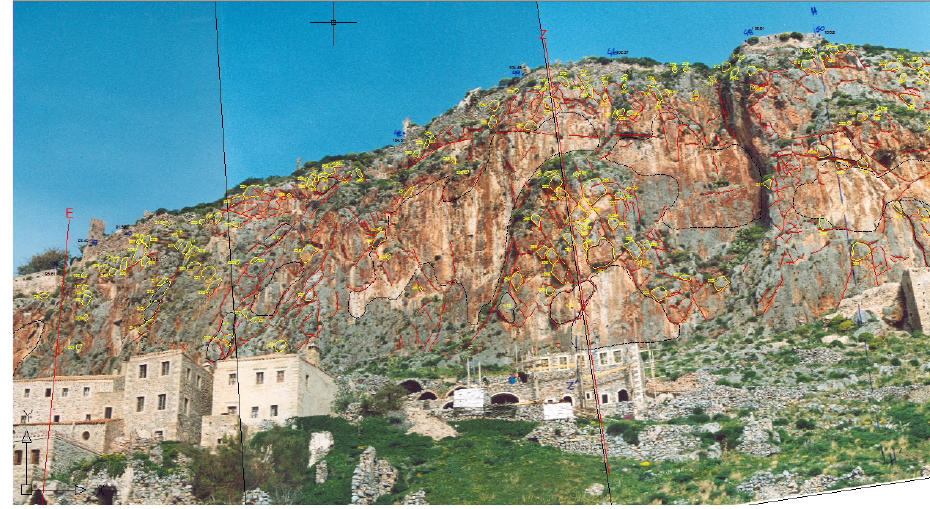
Fig. 5. Potentially unstable blocks in area 4 and 5 are shown in yellow.